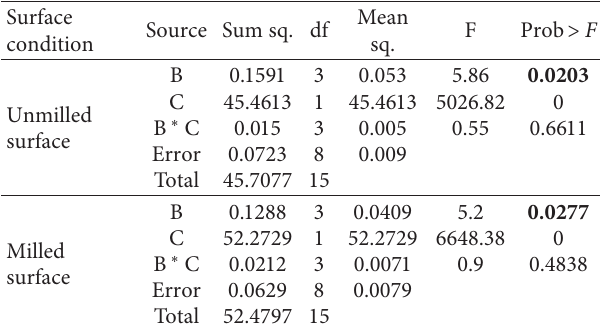
roughness may weaken the fracture performance at intermediate temperatures.